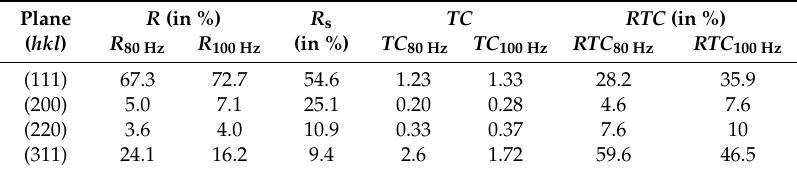
Table 3. Texture calculations for Cu coatings obtained by the PC regimes at frequencies of 80 and 100 Hz; s—Cu